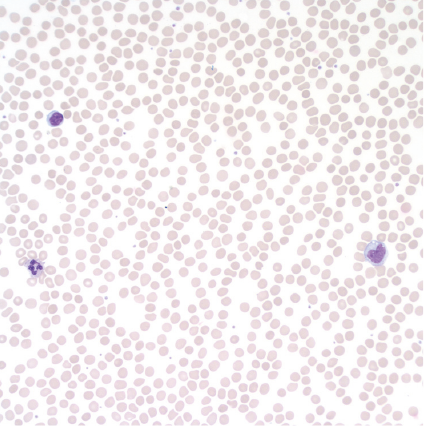
Figure 1: Peripheral blood smear with normocytic normochromic red blood cells. Wright stain, immersion oil 50x.